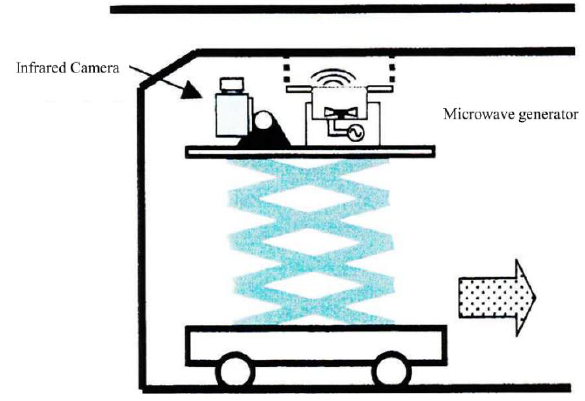
Figure 25. MWT combined with a vehicle [61]. Reprinted/reproduced with permission from SPIE.